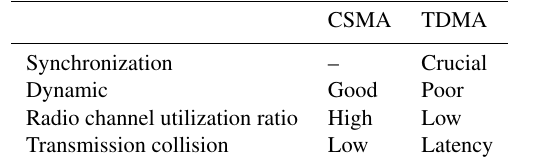
Table 2. Comparison of TDMA and CSMA.